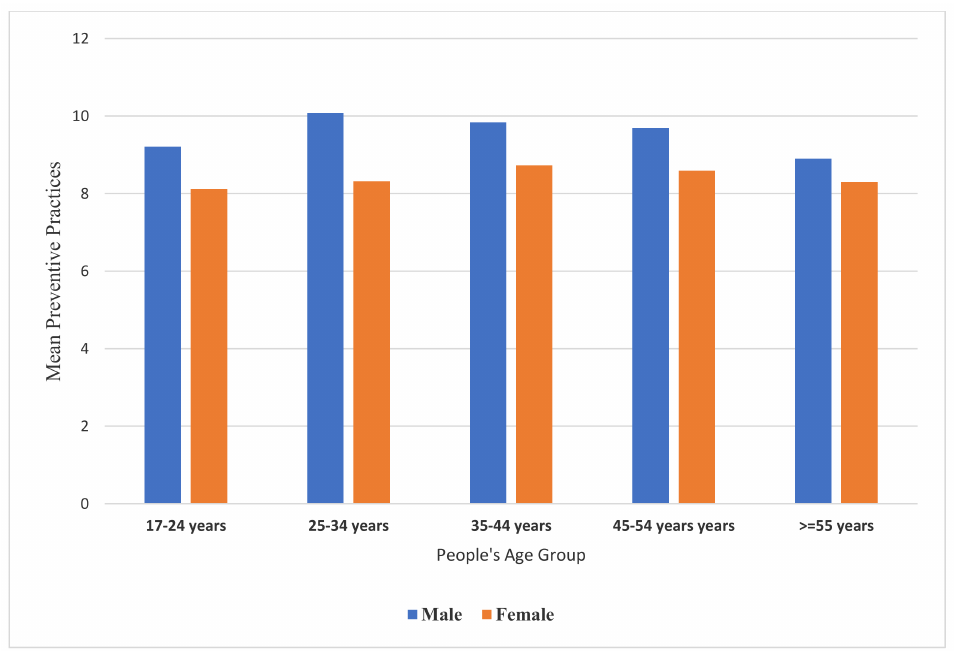
Figure 1. The association between people’s age with their mean practiced COVID-19 preventive measures for both